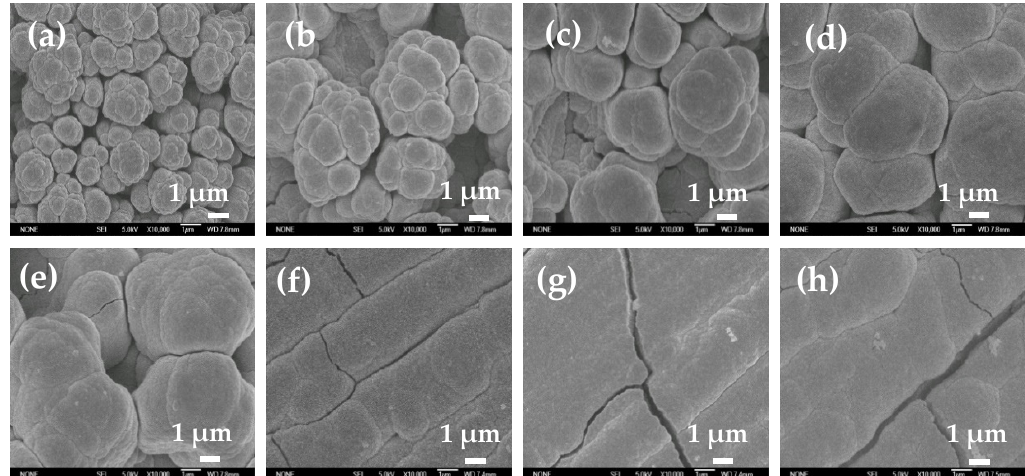
Figure 6. SEM images of Ni films electrodeposited in 0.2 M NiCl 2 , 2 M NH 4 Cl, and 1 M NaCl solutions with different pH values of 3 ( a ), 6.5 ( b ), 7.1 ( c ), 7.7 ( d ), 8.1 ( e ), 8.3 ( f ), and 9.1 ( g ), and with 0.1 M EDTA ( h ). Magnification: 10,000×.